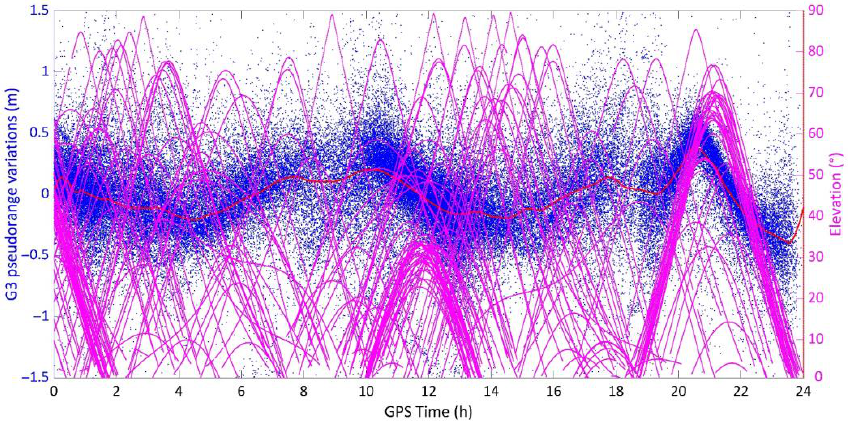
Figure 9. The code pseudorange variations of R21 on DOY 325, 2020, at 145 globally distributed stations. The blue dots denote the code pseudorange variations calculated by the CMC combination, the purple line denotes the elevation angle, and the red line represents the low-frequency components of the code pseudorange variations using wavelet transformation.